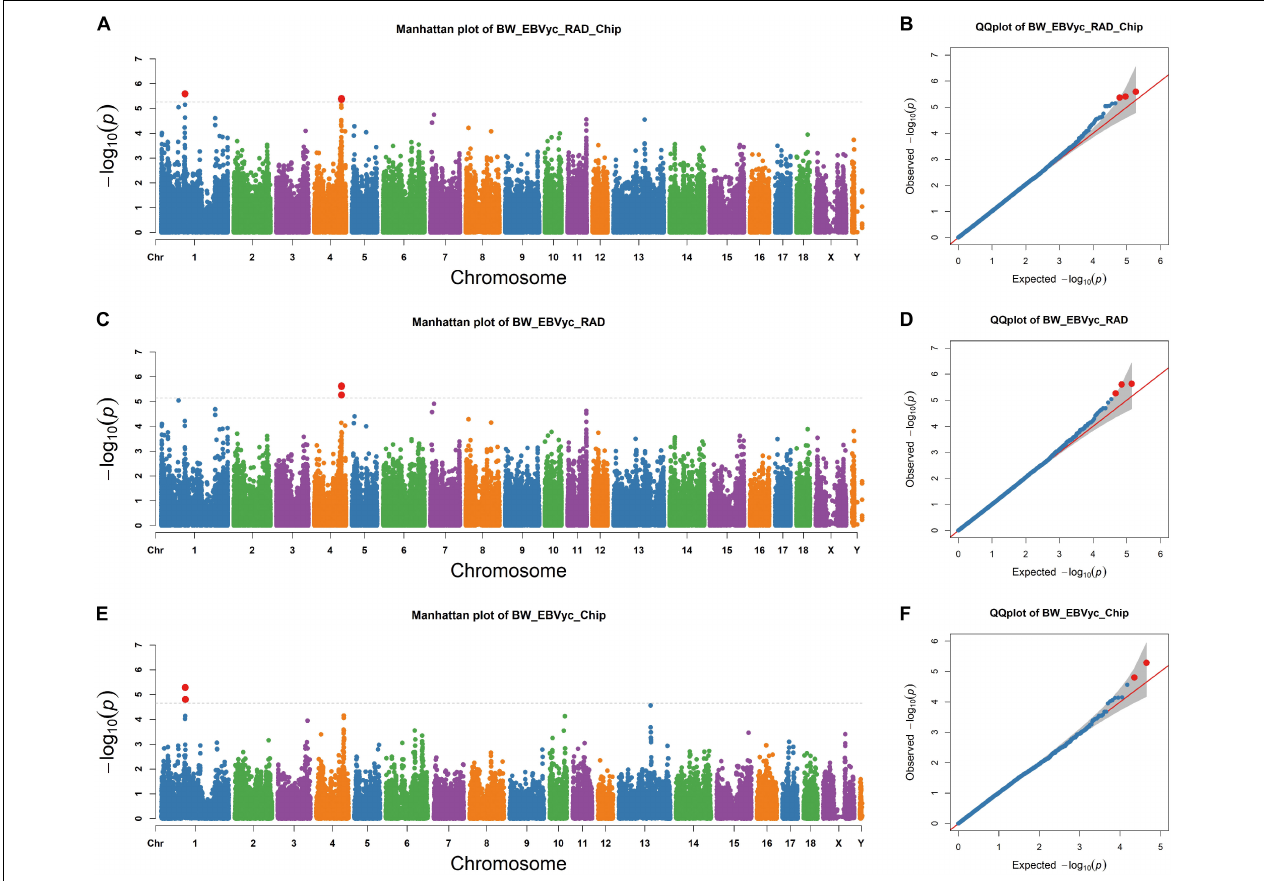
FIGURE 2 | Genome-wide association study (GWAS) profiles from the merged SNPs of RAD-seq and SNP chip assays (A,C,E) and the corresponding Q-Q plot (B,D,F) the horizon lines represent the thresholds as determined by Bonferroni correction.